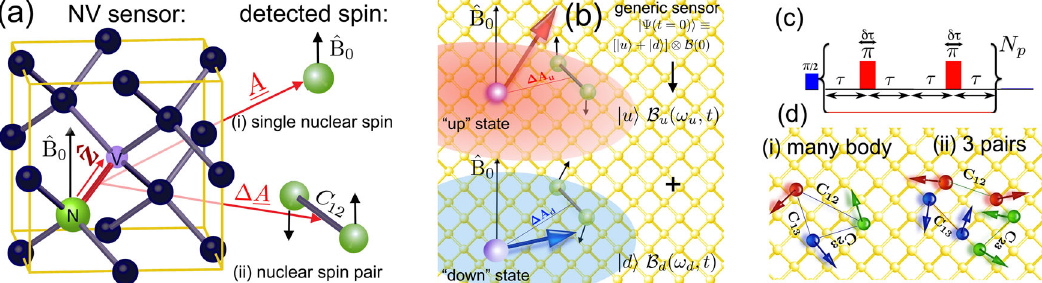
FIG. 1. (a) Current experiments have employed the S ¼ 1 electronic spins of NV centers to successfully detect (i) single nuclear spins [15,21,22], (ii) the internal dynamics of nuclear spin pairs [16], as well to characterize on the atomic scale, by estimating parameters such as electronic-nuclear dipolar couplings A and internuclear dipolar couplings C 12 . (b) Generic sensor detecting a pair of nuclear spins. The electronic spin state is in a superposition of “ up ” j u i and “ down ” j d i states. The nuclear dynamics and its characteristic frequencies ω u;d depend on the electronic state. In turn, the electronic coherence is sensitive to the resulting weak ac noise from the nuclei. This may be amplified by dynamical decoupling control such as CPMG, leading to observed “ dips ” in coherence. These are at well-defined frequencies in typical weak-coupling regimes where the nuclear dynamics is not too different in the u , d subspaces. However, strong-coupling regimes do not necessarily yield sharp dips. (c) Additional complexities occur for pulses of finite durations. (d) It is also challenging to differentiate between (i) independent pairs of spins and (ii) many-body effects from an equivalent interacting cluster. Floquet theory is not restricted to single spins or spin pairs and can be applied also to analysis of larger, correlated spin clusters, strong coupling, and off-resonant